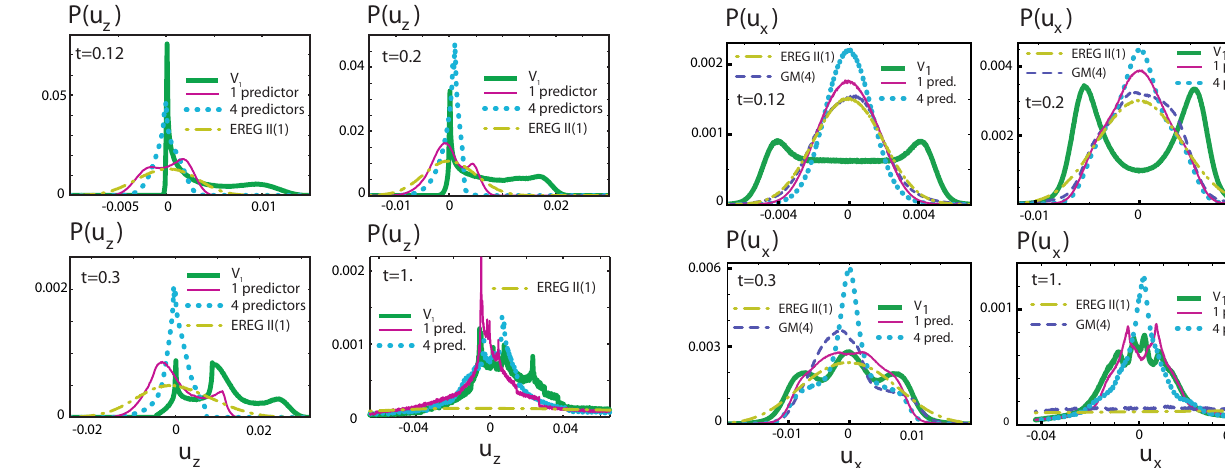
u z Fig. 7. The distributions of the error variable u z of the Lorenz model with large model error ( (cid:14)r =10 (cid:0) 2 ) and Fig.8. Thedistributionsoftheerrorvariable u x oftheLorenzmodelwithsmallmodelerrors( (cid:14)r =2 : 5 (cid:2) 10 (cid:0) 3 ) Fig. 7. The distributions of the error variable u z of the Lorenz model Fig. 8. The distributions of the error variable u x of the Lorenz without initialconditionerror,at t =0 : 12 ; 0 : 2 ; 0 : 3 ; 1 . Thelinesindicatedwith“1predictor”and“4predictors” and with initial condition error, at t =0 : 12 ; 0 : 2 ; 0 : 3 . The lines indicated with “1 predictor” and “4 predictors” with large model error ( δr = 10 − 2 ) and without initial condition model with small model error ( δr = 2 . 5 × 10 − 3 ) and with initial applytoallregressionmethodsexceptforGMandEREGII.Theresultsaregeneratedusing 2 (cid:2) 10 6 ensembles. applytoallregressionmethodsexceptforGMandEREGII.Theresultsaregeneratedusing 5 (cid:2) 10 5 ensembles error, at t = 0 . 12 , 0 . 2 , 0 . 3 , 1. The lines indicated with “1 predictor” condition errors, at t = 0 . 12 , 0 . 2 , 0 . 3. The lines indicated with “1 of 500 members. and “4 predictors” apply to all regression methods except for GM predictor” and “4 predictors” apply to all regression methods ex- and EREG II. The results are generated using 2 × 10 6 ensembles. cept for GM and EREG II. The results are generated using 5 × 10 5 ensembles of 500